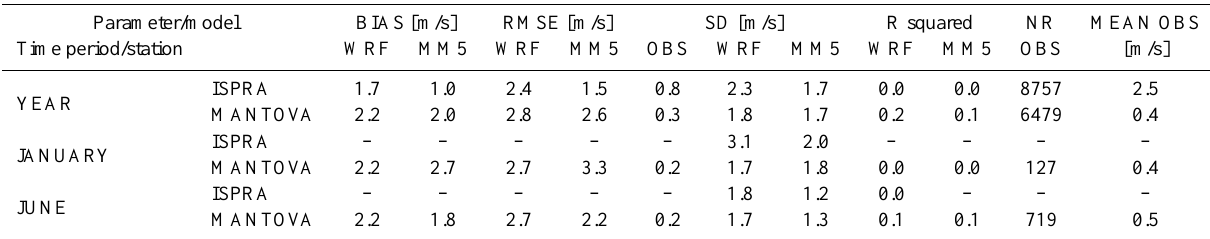
Table 3c. Statistics for the wind speed.